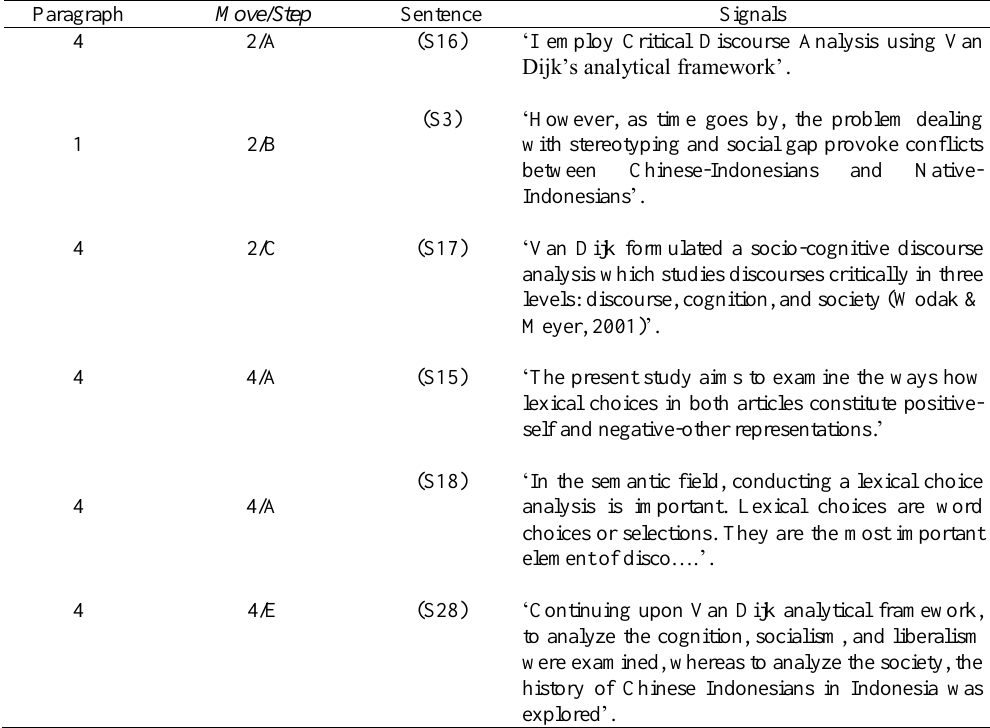
Move and Step in Research Article Introduction (RAI) in article 1.3 Research